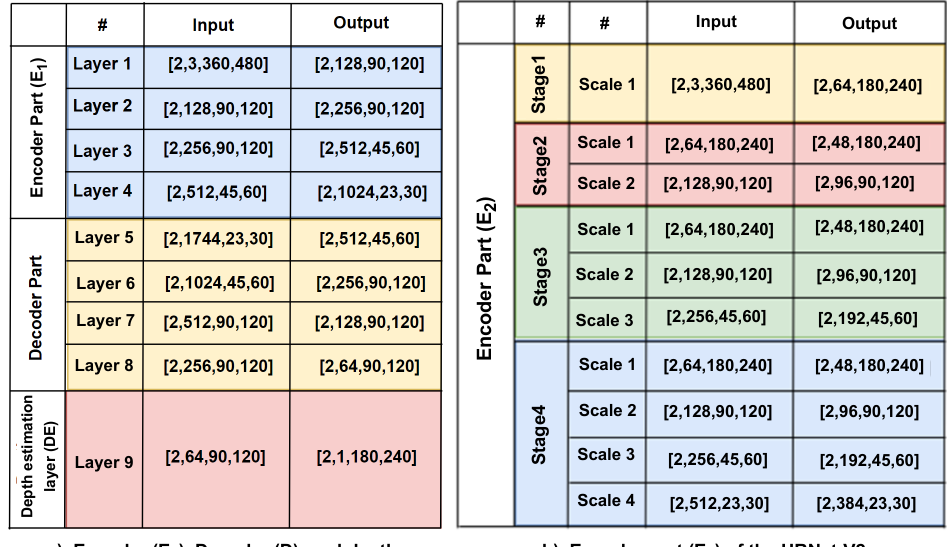
Figure 3. ( a ) Input and output sizes of each layer in the encoder E 1 and decoder D parts for the autoencoder network. ( b ) Input and output sizes of each scale in the encoder part E 2 of the HRNet-V2 Network. Colours correspond to the colours used in Figure